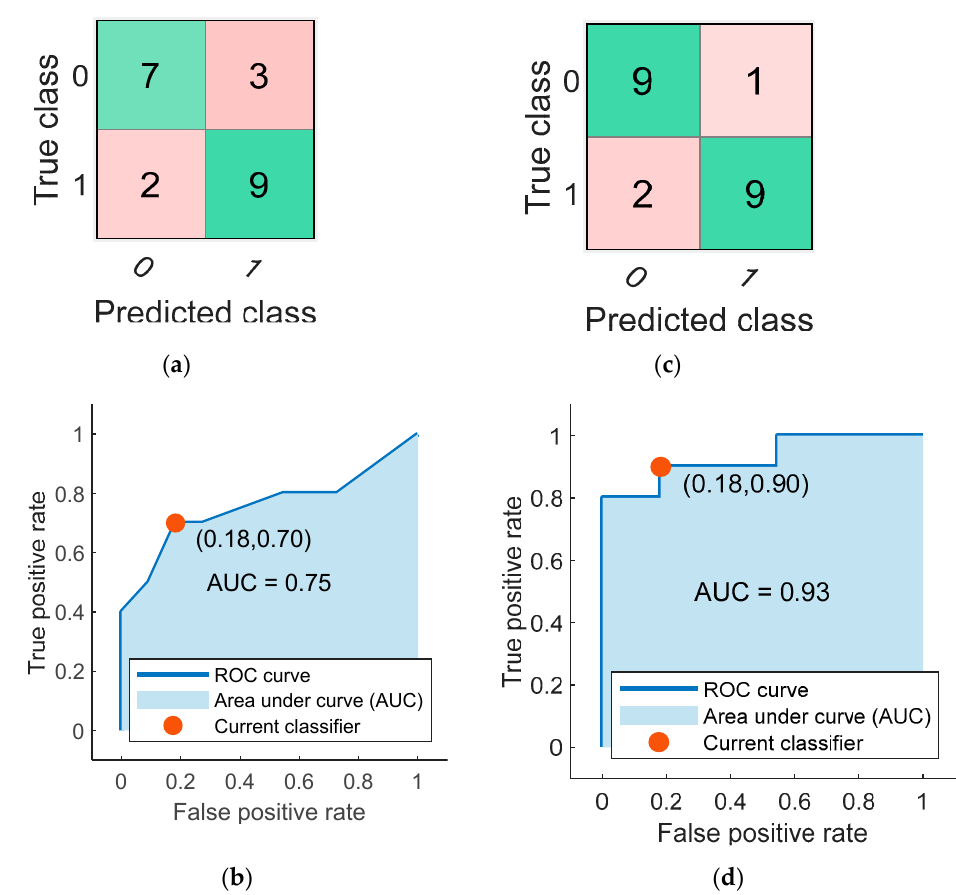
Figure 4. The confusion matrices and the receiver operating characteristic (ROC) curves for the best classifiers trained separately using the best five features identified using mRMR ( a , b ) and ReliefF ( c , d ). Class “0” is the placebo group, arbitrarily taken as the “positive” group, and class “1” is the rosuvastatin group, taken as the “negative” group. Table 5. Performances of classifiers built with features selected through both techniques.